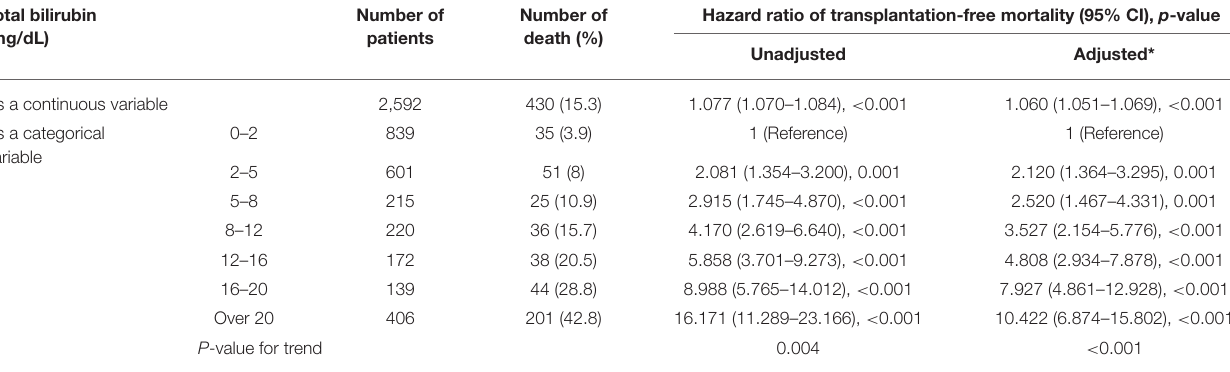
TABLE 3 | The unadjusted and adjusted hazard ratios of 90-day transplantation-free mortality due to total bilirubin in patients with cirrhosis. Total bilirubin (mg/dL)